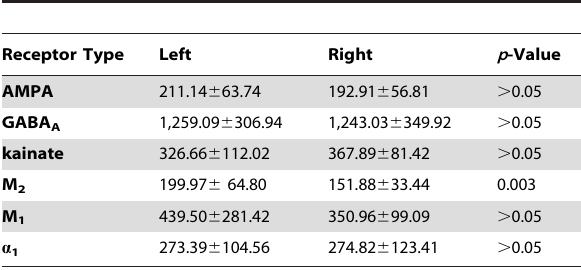
Table 3. Normalized receptor densities and standard deviations (averaged over all areas) for each receptor type.